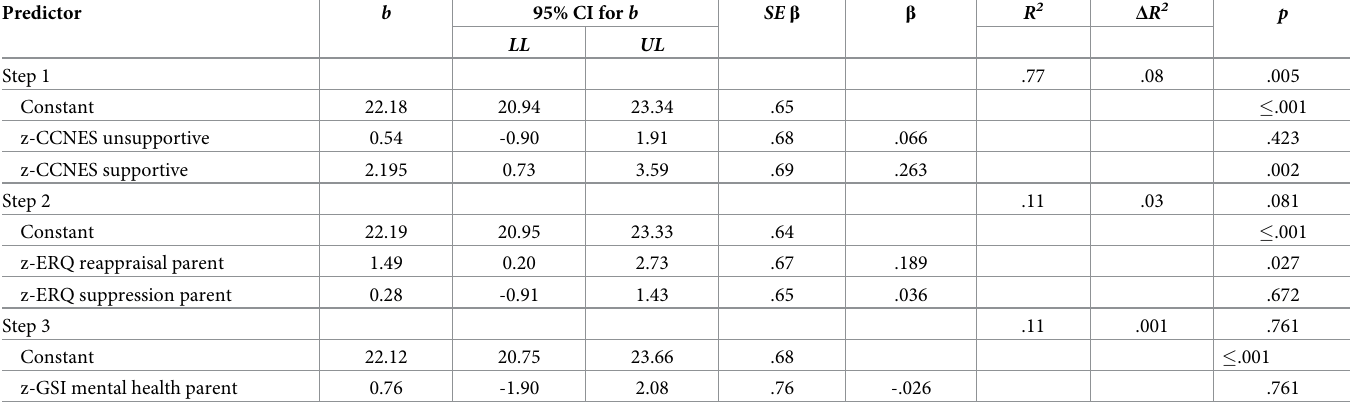
Table 6. Unstandardized (b) and standardized ( β ) regression coefficients for each predictor in a hierarchical regression model predicting reappraisal in children. Predictor